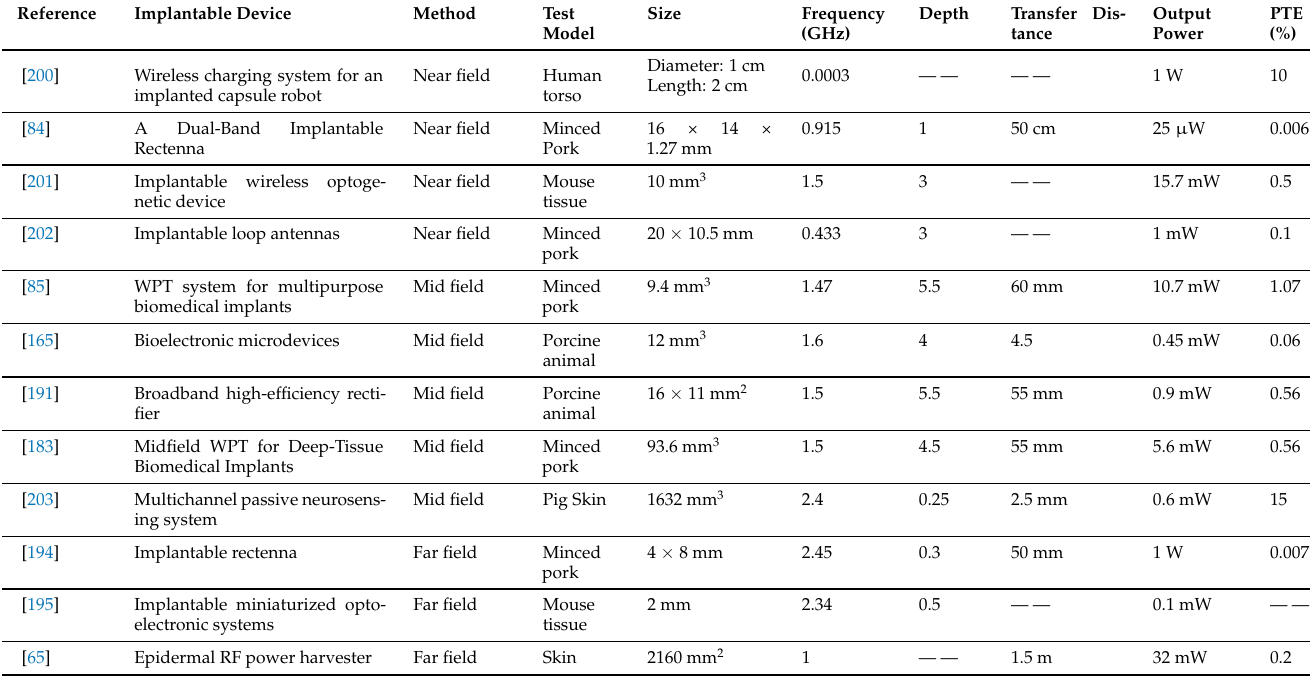
Table 6. Comparison of implantable RF energy harvester